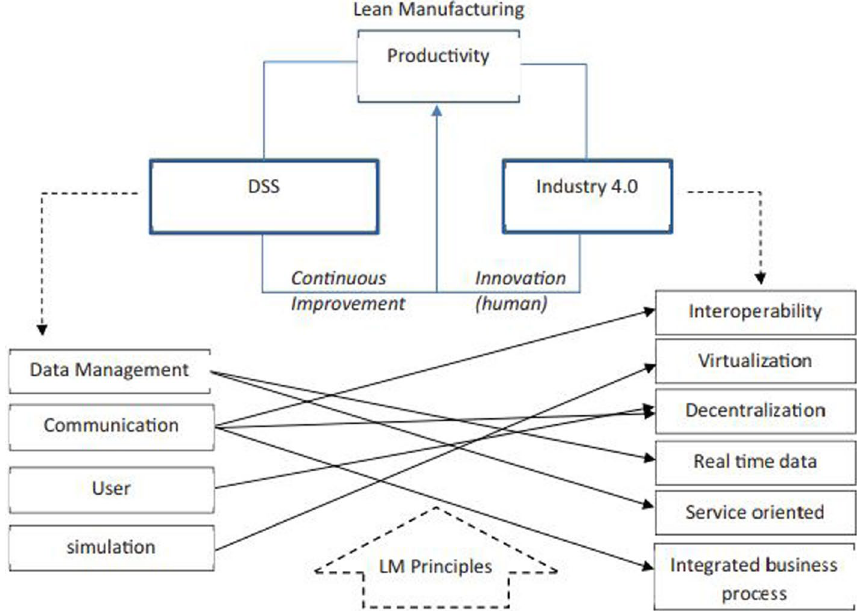
Fig. 3 Concept of DSS design based on KBE (Source: Prasad,